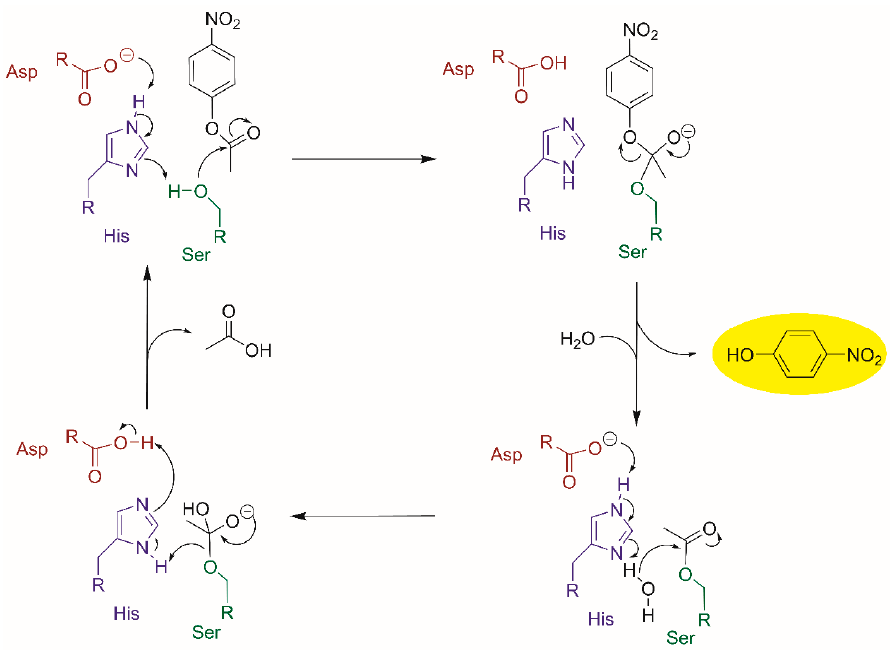
Scheme 1. Example of catalytic mechanism of serine proteases for the hydrolysis of 4-nitrophenyl acetate, a common substrate, that leads to the formation of the yellow-colored 4-nitrophenol that can be measured spectrophotometrically.